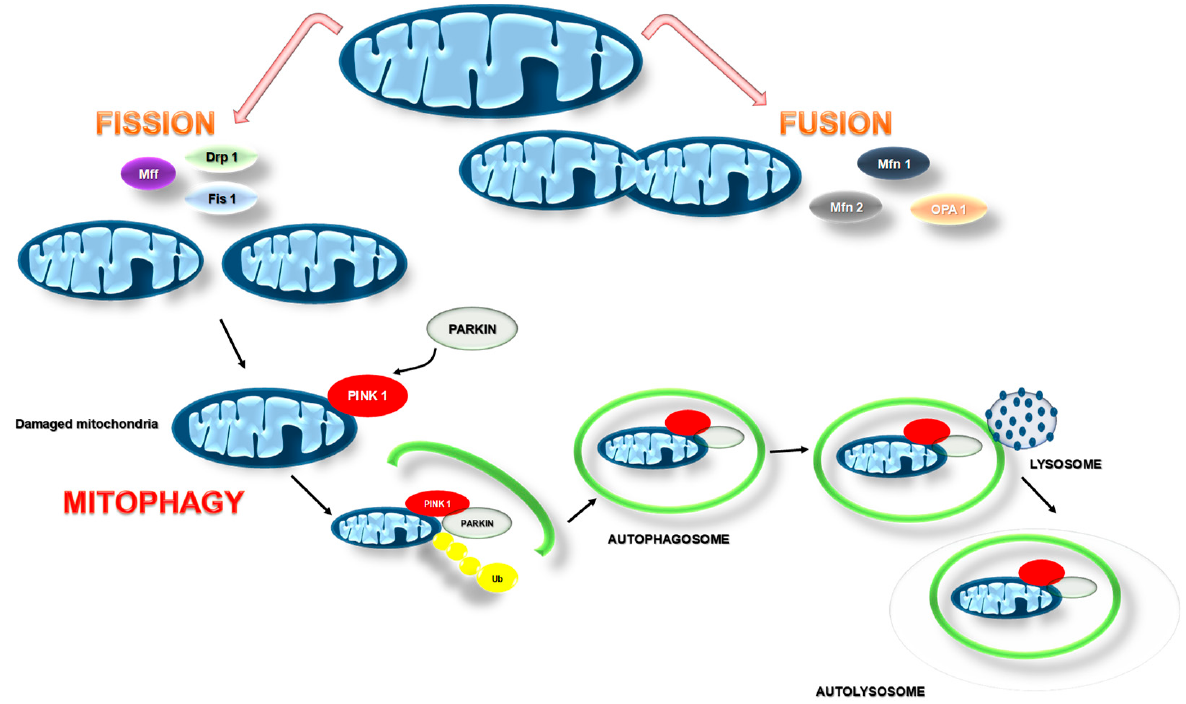
Figure 3. The scheme of mitochondrial dynamics and mitophagy. Mitochondrial fusion and fission processes are responsible for a healthy mitochondrial network through the segregation and subsequent degradation of damaged mitochondria. Mitochondrial fusion is a two-step process. The fusion of the outer mitochondrial membrane is regulated by Mfn1 (Mitofusin 1) and Mfn2 (Mitofusin 2), whereas fusion of the inter mitochondrial membrane is mediated by OPA1 (optic dominant atrophy 1) and mitochondria-specific cardiolipin (CL). Mitochondrial fission is mediated predominantly by Drp1 (a dynamin superfamily GTPase) and recruited to scission sites by resident outer-membrane proteins including Mff (mitochondrial fission factors) and Fis1 (mitochondrial fission 1 protein). The fission process generates fragmented mitochondria, which are conducive to the sequestration of injured fragments for subsequent degradation through mitophagy. PTEN-induced kinase 1 (PINK1) and the Parkin pathway regulate the initiation of mitophagy. Mitochondrial damage results in the accumulation of PINK1 on the outer mitochondrial membrane, where it phosphorylates polyubiquitin chains linked to mitochondrial outer membrane proteins. Next, phospho-S65-ubiquitin binds to Parkin, recruiting it from the cytosol and activating Parkin’s E3 ubiquitin ligase activity. This complex is identified by ubiquitin-SQSTM1(multifunctional adaptor protein sequestosome 1)-LC3 (microtubule-associated protein 1 light chain 3) autophagosome targeting and is degraded following lysosomal